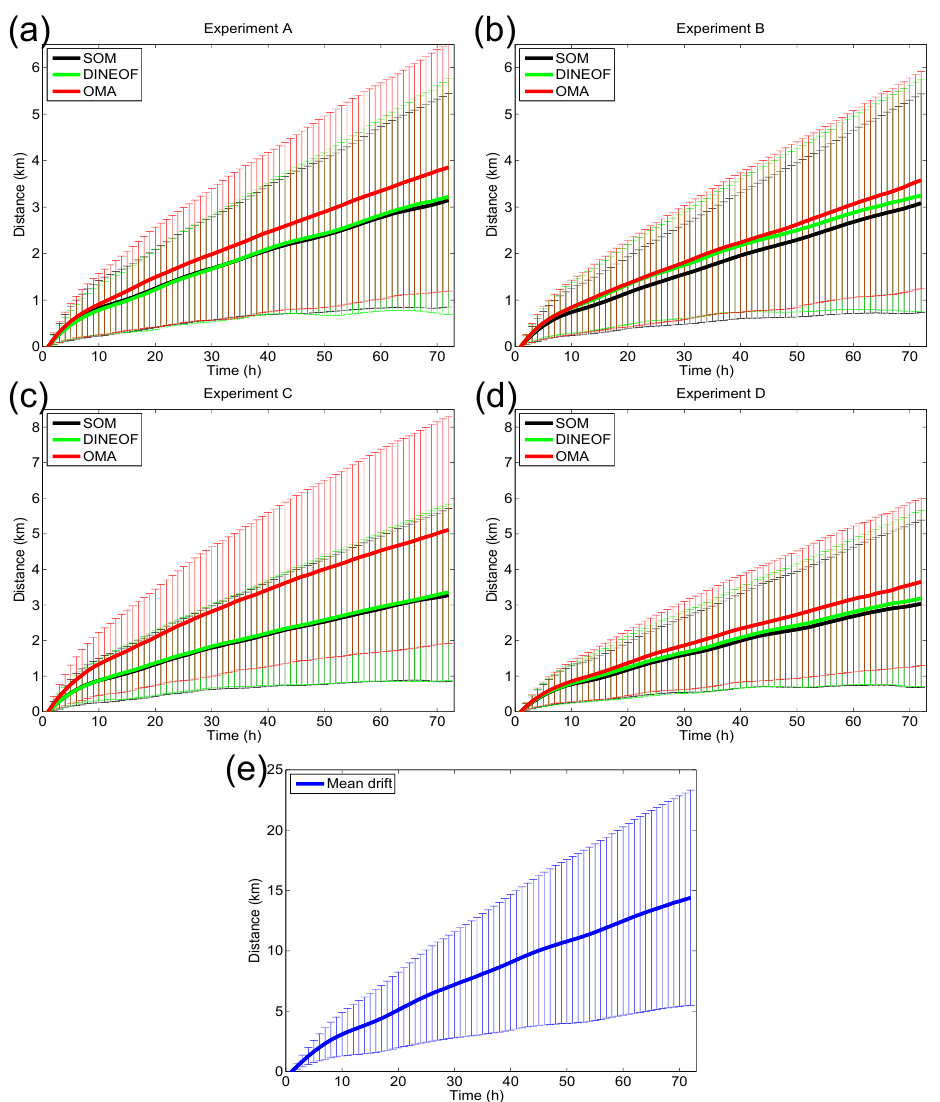
Figure 7. Separation distance between particle trajectories advected by the filled HFR velocity field and by the reference velocity field as a function of time and averaged over all the pairs of trajectories. Different limits in the vertical axis of the figure have been used for a better data representation. The error bar is the confidence interval (1 standard deviation) of the spatial average of D(t)